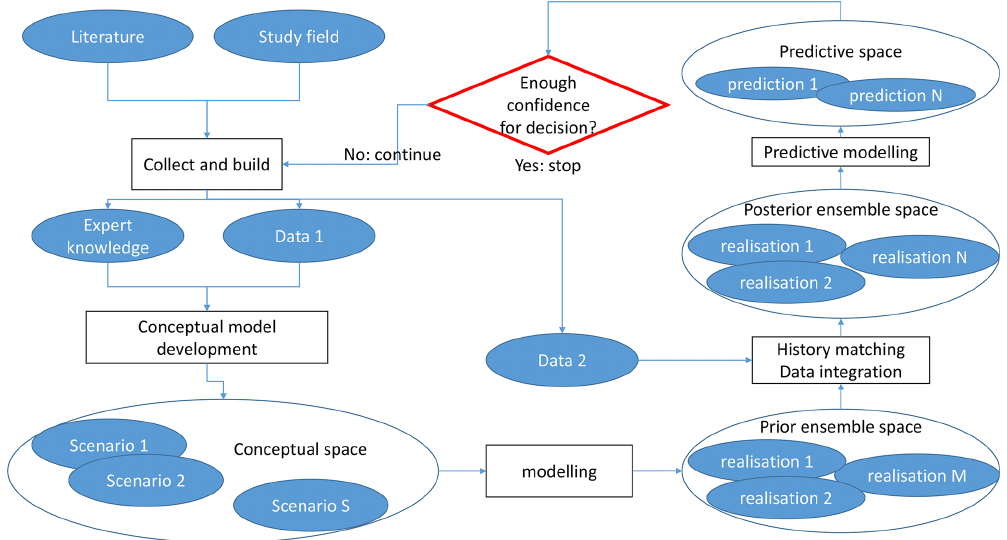
Figure 2. Schematic representation of a geomodelling workflow; each ellipse is associated with some uncertainty; Data 1 (e.g. geological observations) is used only to build a prior ensemble of models; Data 2 (e.g. geophysical measurements) is used to reduce the number of models that can be considered. It is achieved by exploring the ensemble of prior models and selecting those that are more likely to reproduce Data 2 within a prescribed level of